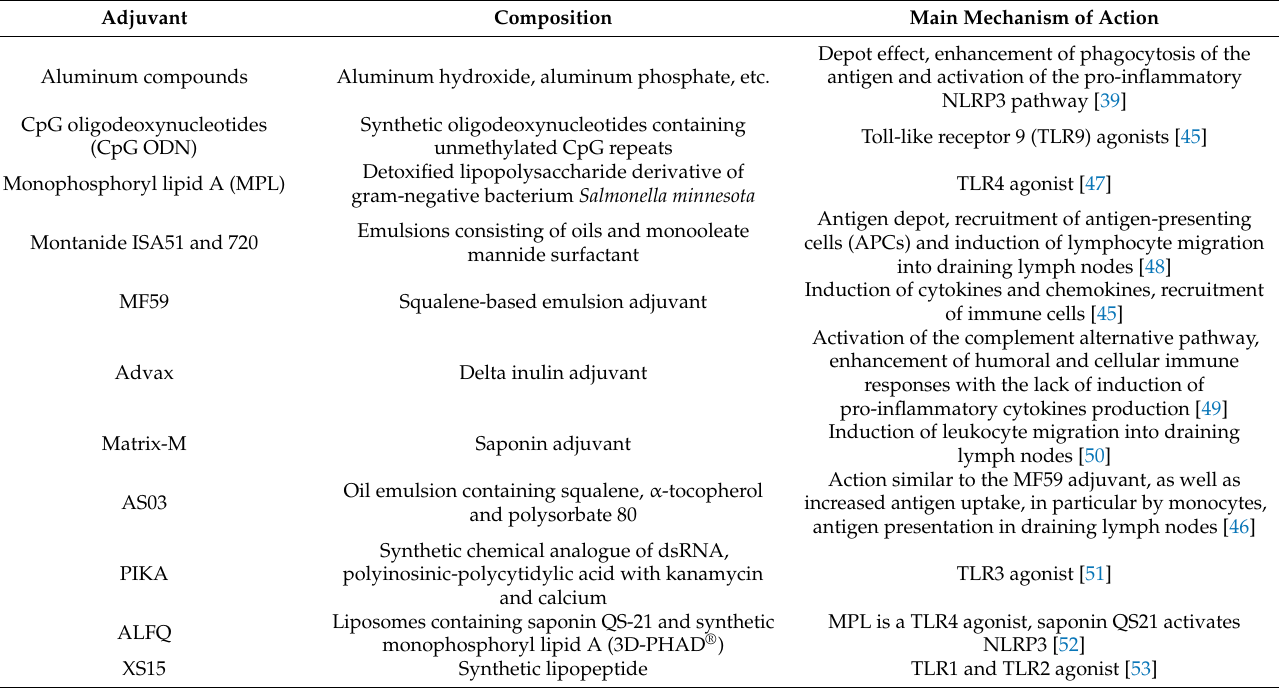
Table 1. Some adjuvants used in recombinant protein COVID-19 vaccines approved for clinical trials